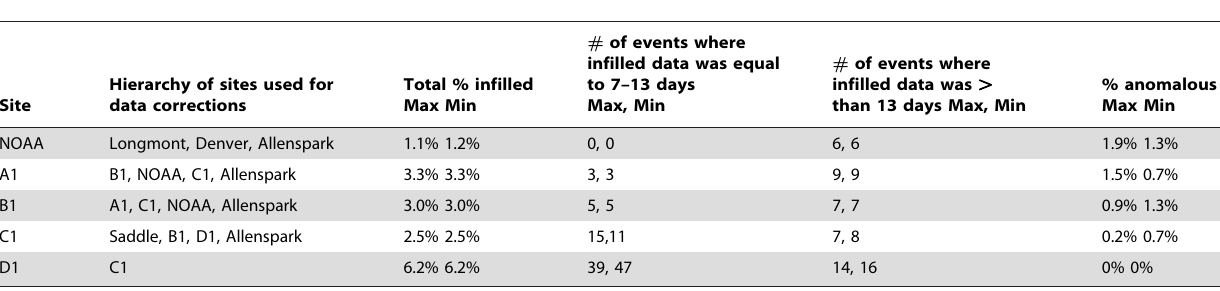
Table 2. Hierarchy of sites used to infill and correct anomalous data at each weather station.